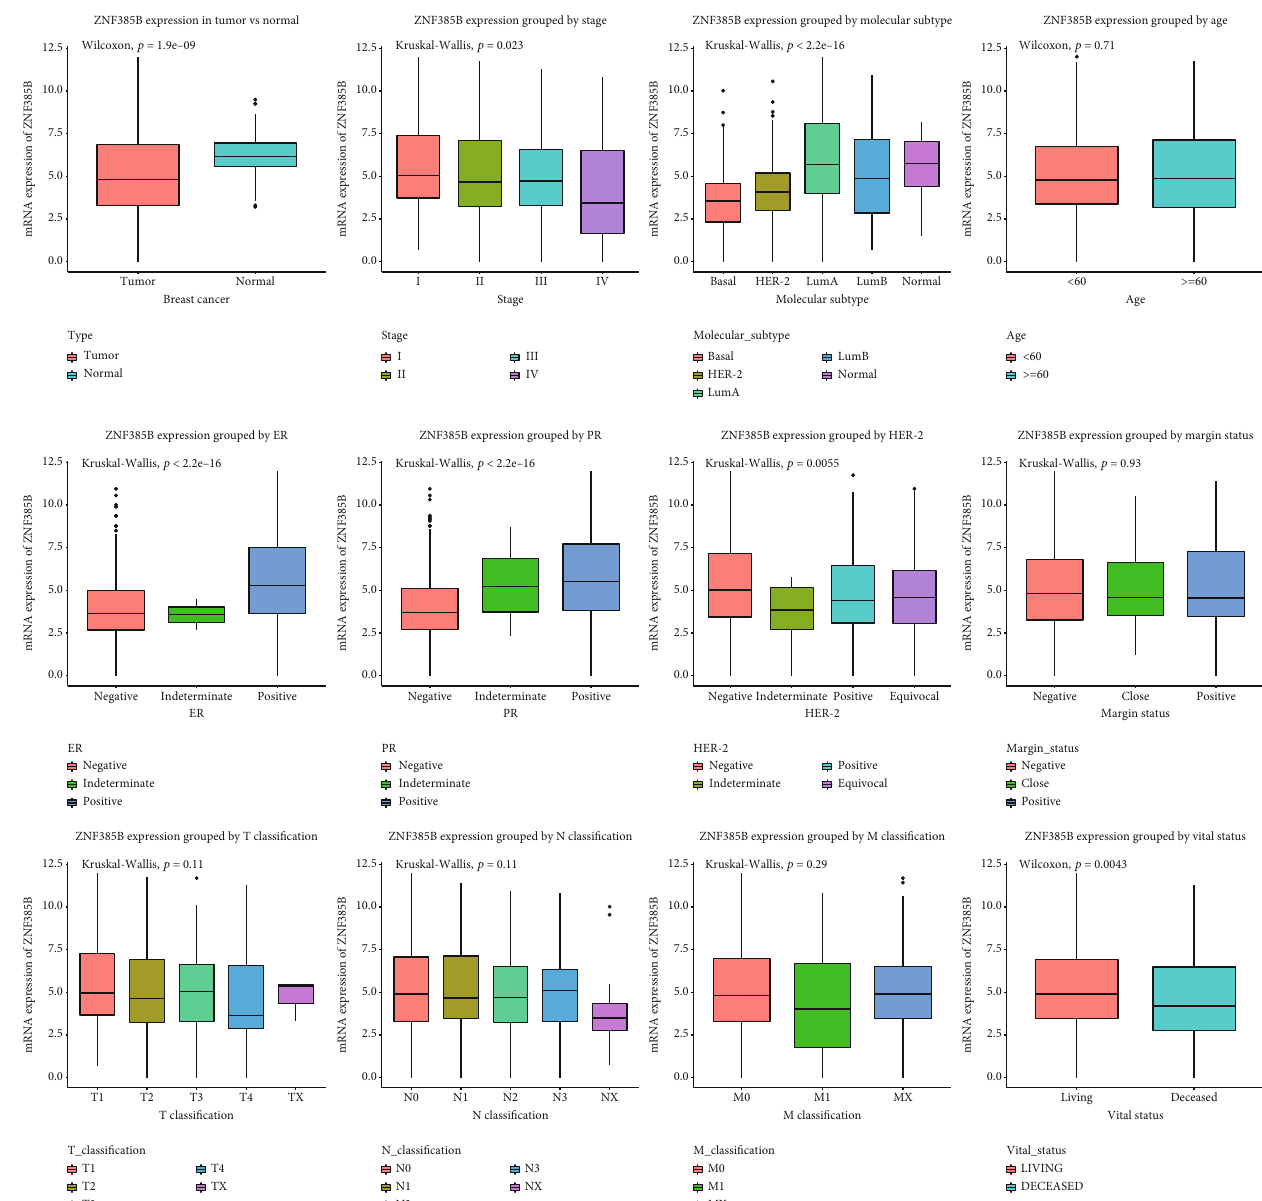
Figure 1: ZNF385B expression in breast tumor. The expression of ZNF385B is signi fi cantly lower in tumor than normal tissue. Low ZNF385B expression closely related with TNM stage, molecular subtype, ER, PR, HER-2 and vital